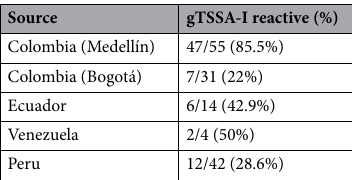
Table 1. Recognition of gTSSA-I by chagasic sera from northern South